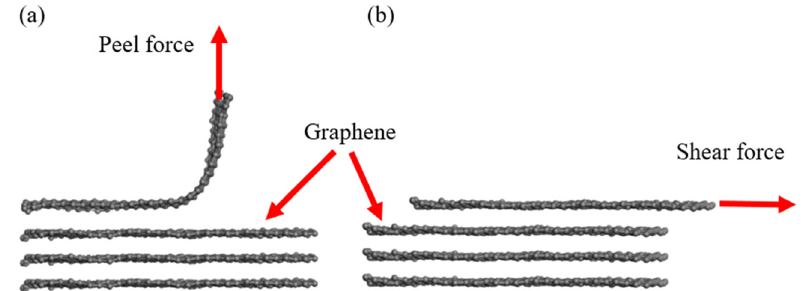
Figure 1: Schematics of mechanical exfoliation to obtain a single layer of graphene by applying ( a ) peel force and ( b ) shear force.